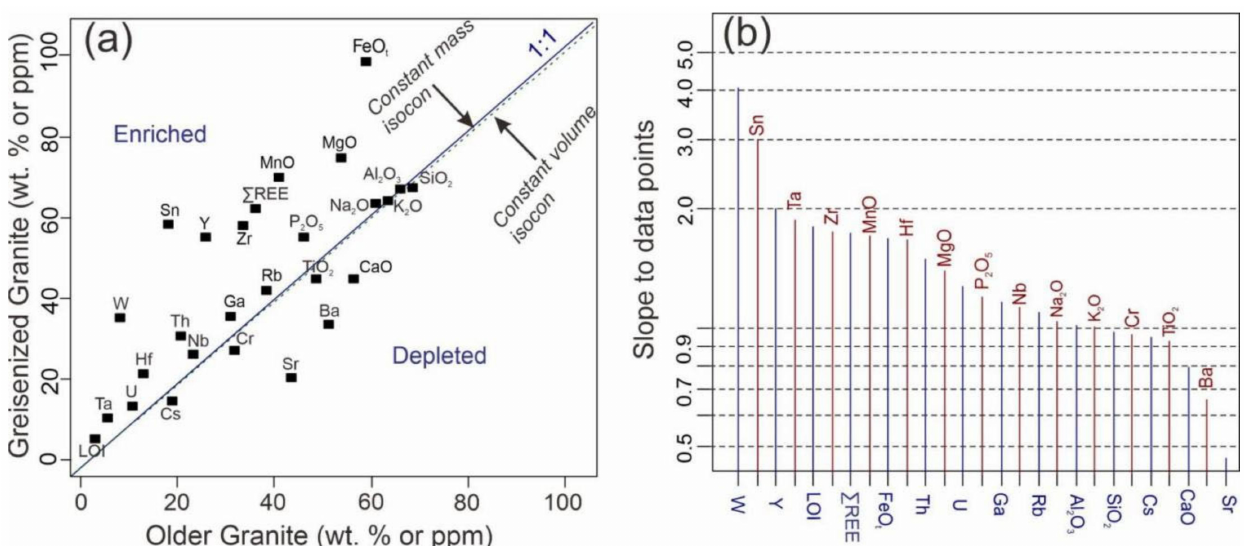
Figure 9. Isocon analysis of the host Older Granite vs. Greisenized granite from the Gindi Akwati deposit. ( a ) Isocon diagram. The element contents of Older Granite and greisenized granite use the average value of samples analyzed in this study (according to [36]); ( b ) Clustering slopes of elements for the selected, presumably immobile, species (according to